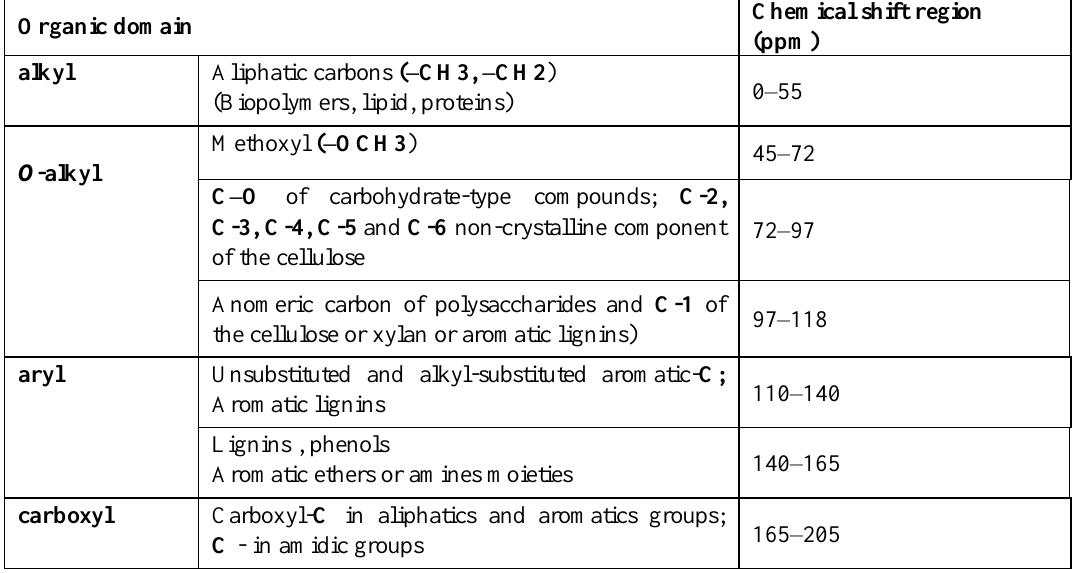
Table 1. Chemical shift region of 13 C-NMR spectra and assignment to the corresponding organic domains. Data was compiled from the following references